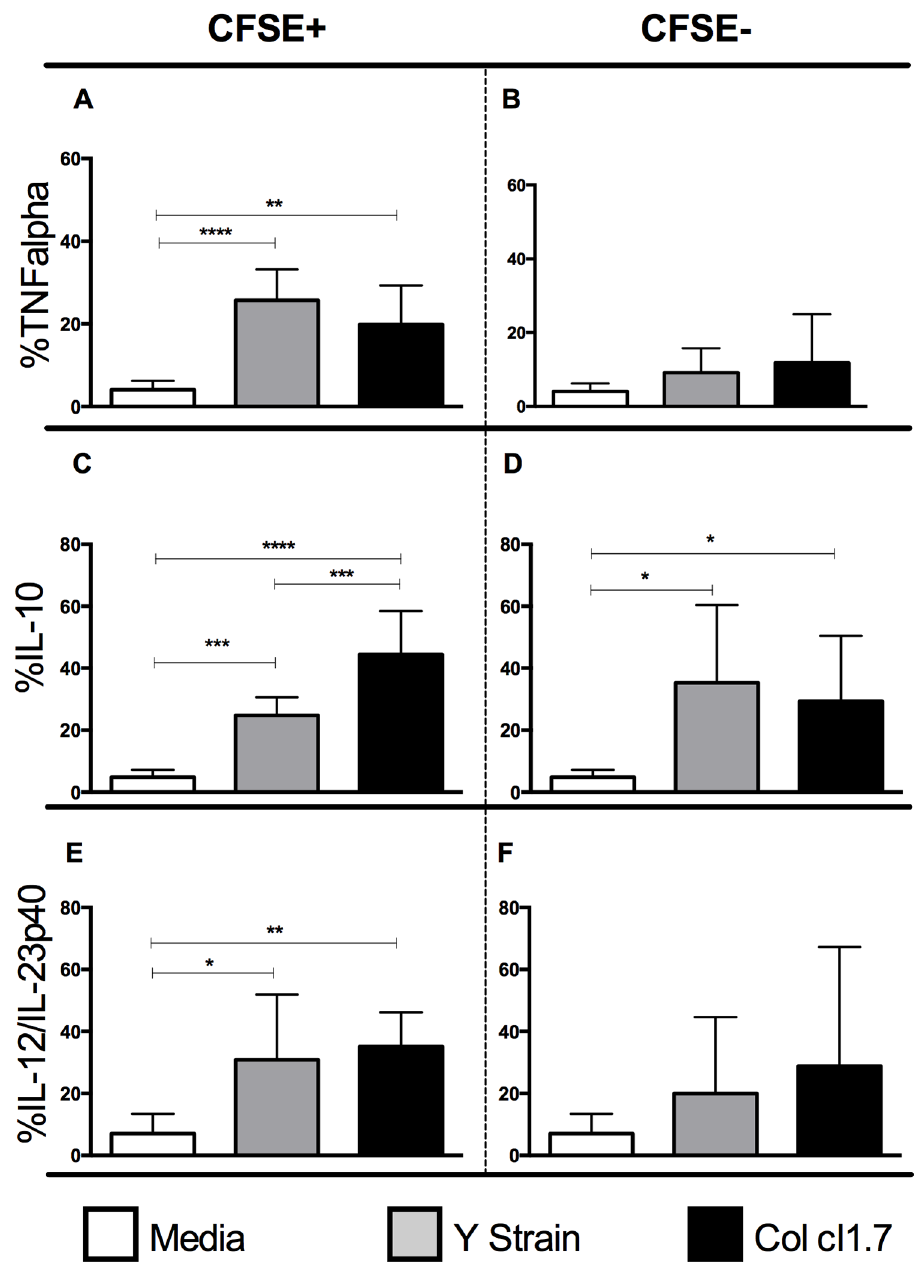
Fig 3. Determination of the percentage of expression of the cytokines TNF-alpha, IL-12/IL-23p40 and IL-10 by human monocytes infected or not with different strains of T . cruzi . Results are expressed as average ± standard deviation. The symbol * indicates p < 0.05 between groups. Determination of percentage of (A) TNF-alpha in CFSE+ monocytes; (B) TNF-alpha in CFSE- monocytes; (C) IL-12/IL-23p40 in CFSE + monocytes; (D) IL-12/IL-23p40 in CFSE- monocytes; (E) IL-10 in CFSE+ monocytes; (F) IL-10 in CFSE- monocytes; All analysis done after 15 hours of